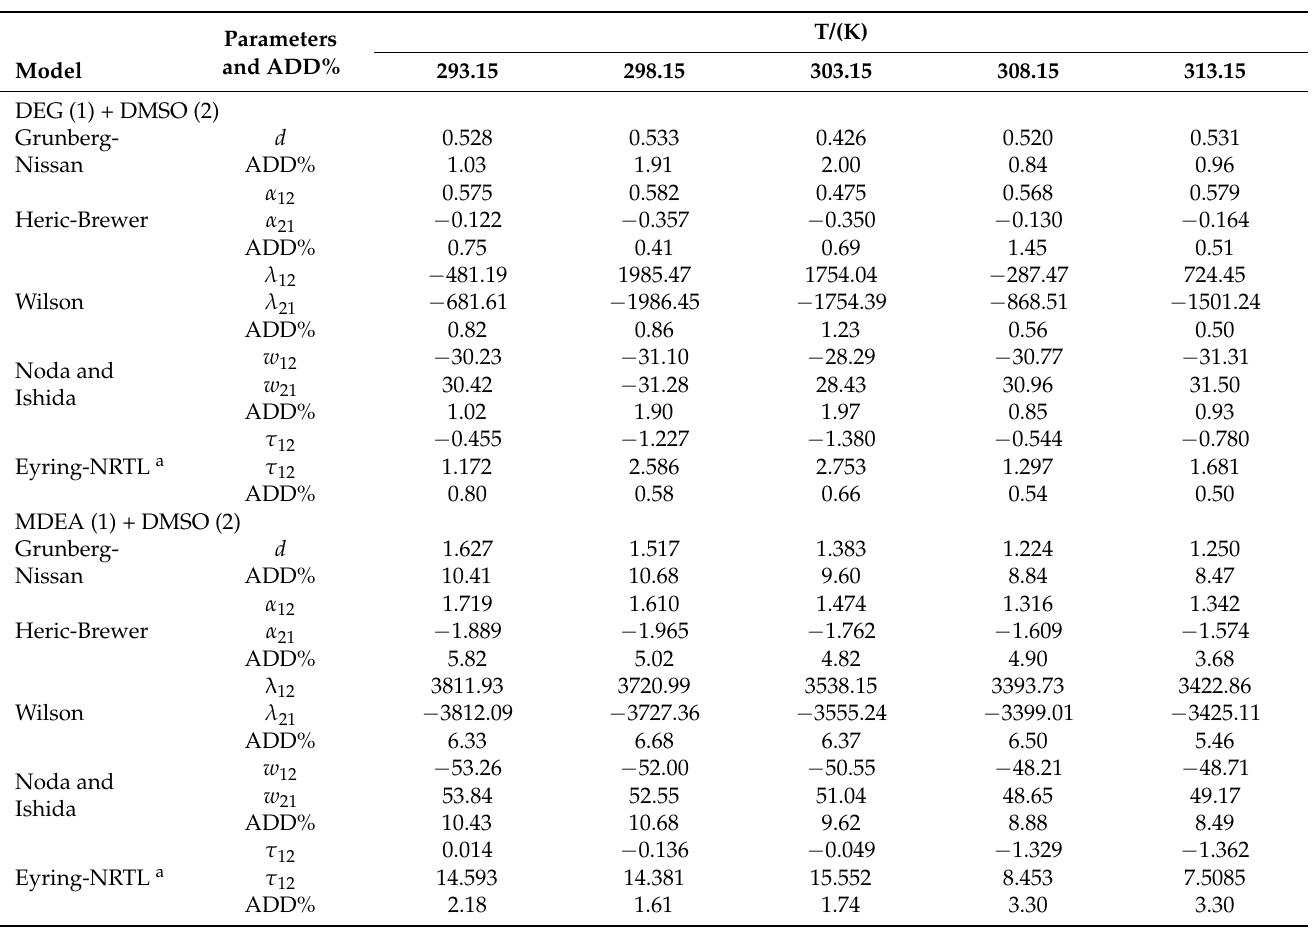
Table A3. Values of parameters for the relations of Grunberg–Nissan, Heric–Brewer, Wilson, Noda– Ishida and Eyring–NRTL and average absolute deviation in the temperature range from 293.15 to 313.15 K.